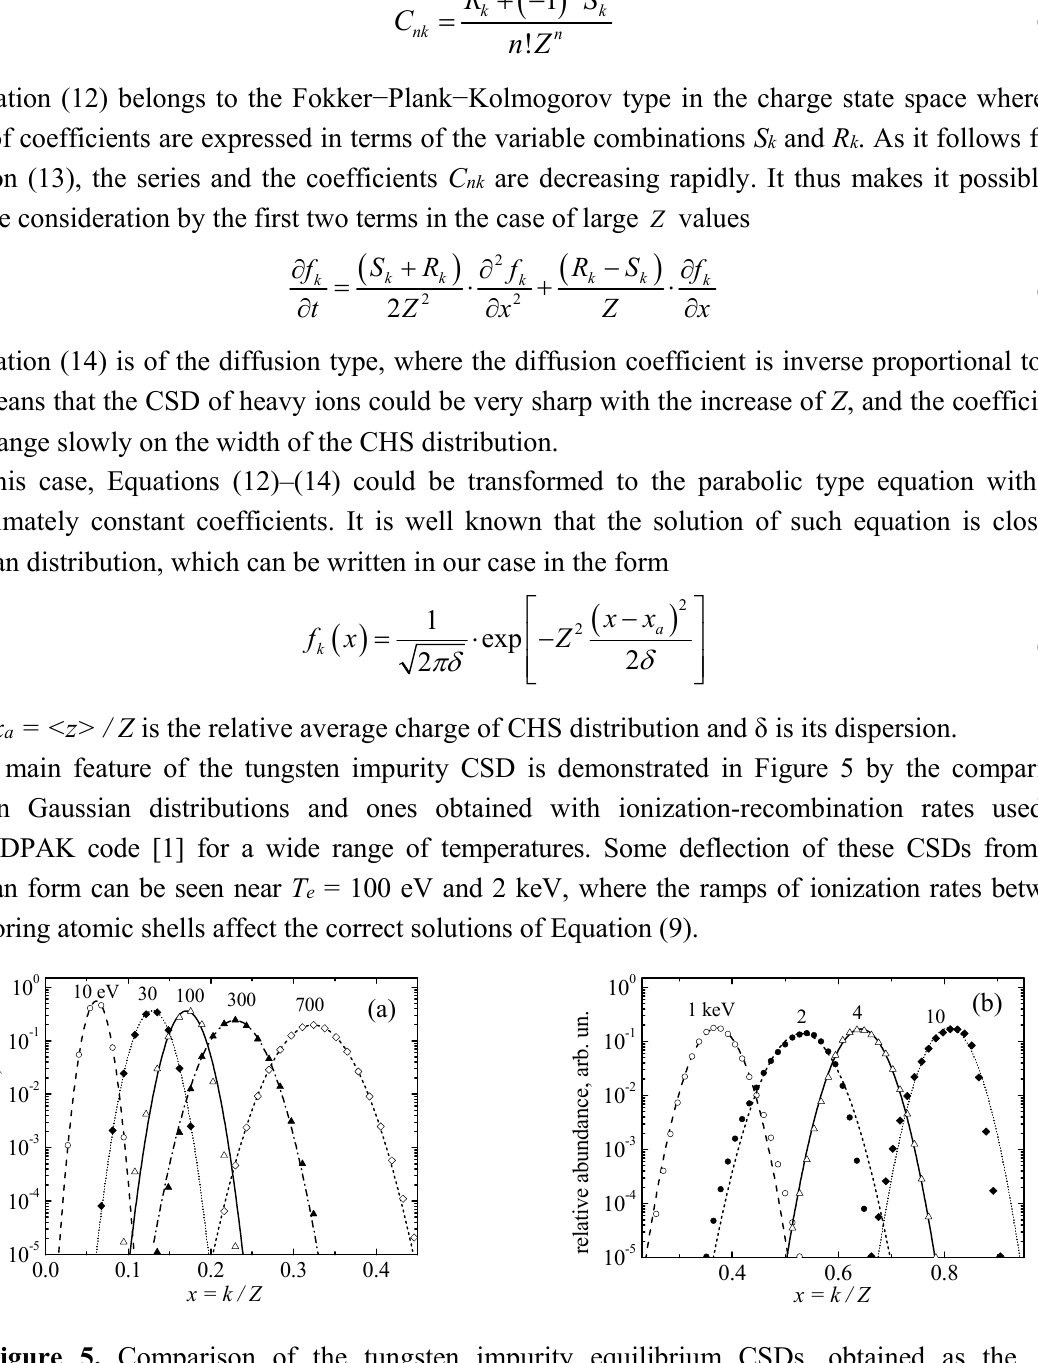
Figure 5. Comparison of the tungsten impurity equilibrium CSDs, obtained as the steady-state solutions of Equation (9), with the Gaussian distributions, calculated by Equation (15): ( a )—for T e < 1 keV; ( b )—for T e > 1 keV (the curves are labeled by corresponding T e